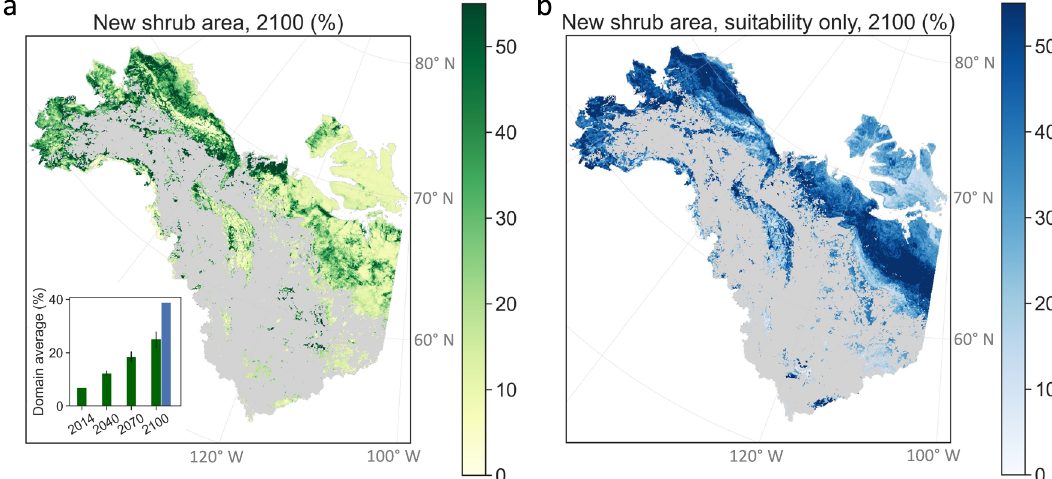
Fig. 3 A quarter of non-woody tundra in 1984 will be colonized by shrubs by 2100 based on the climate scenario RCP8.5. Spatial pattern of new shrub area in 2100 predicted using ( a ) environmental suitability, dispersal, and fi re, and ( b ) environmental suitability alone. The inset of ( a ) shows the domain average of new shrub area predicted with (green bars) and without (blue bar) considering dispersal and fi re. The vertical black lines span the upper and lower boundaries due to the uncertainty of the estimated sensitivities ( n = 533, see “ Methods ” for details), i.e., vertical black lines in Fig. 2a. Using environmental suitability alone overestimates shrub expansion and misrepresents the spatial pattern.